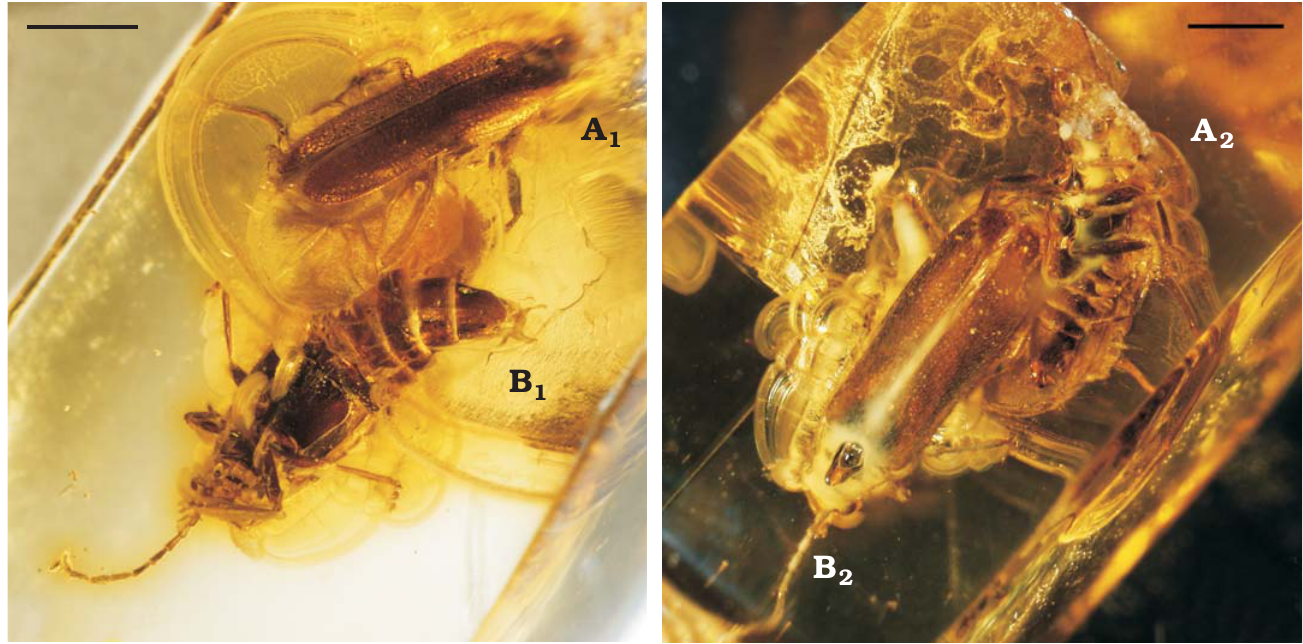
Fig. 1. Soldier beetle Kuskaella macroptera gen. et sp. nov. in Baltic amber, middle Eocene to late Eocene; Poland, Gda ń sk region. A . Holotype, UCP ) and ventral (A ) views. B . Paratype, UCP UwB 222b, female in ventral (B UwB 222a, male in dorsal (A 1 2